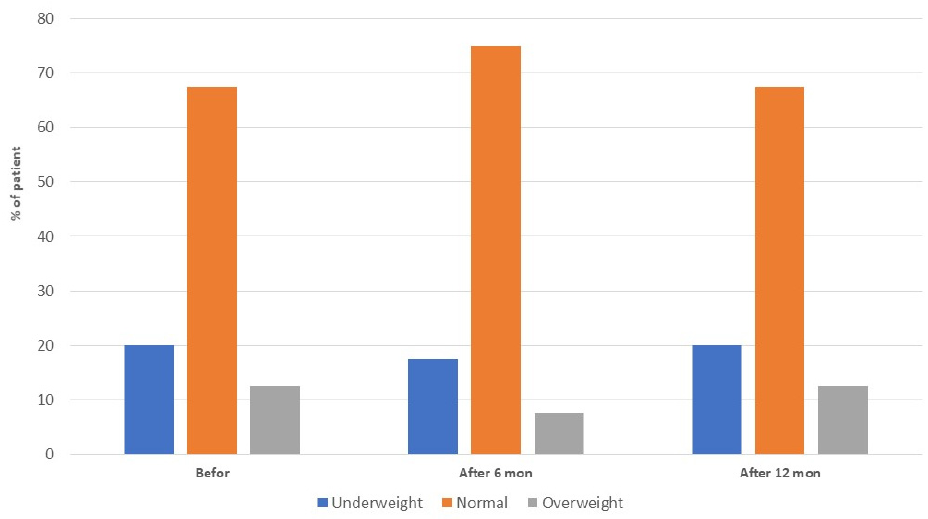
Figure 3. Classification of study participants according to BMI percentiles at the three time points.